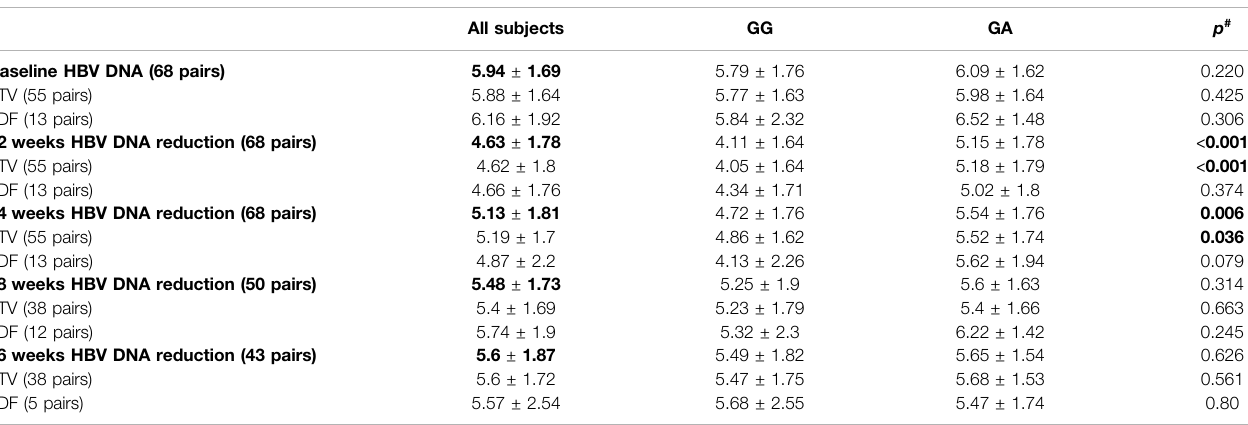
TABLE 4 | §HBV DNA Reduction between wild-type control and heterozygote cases.